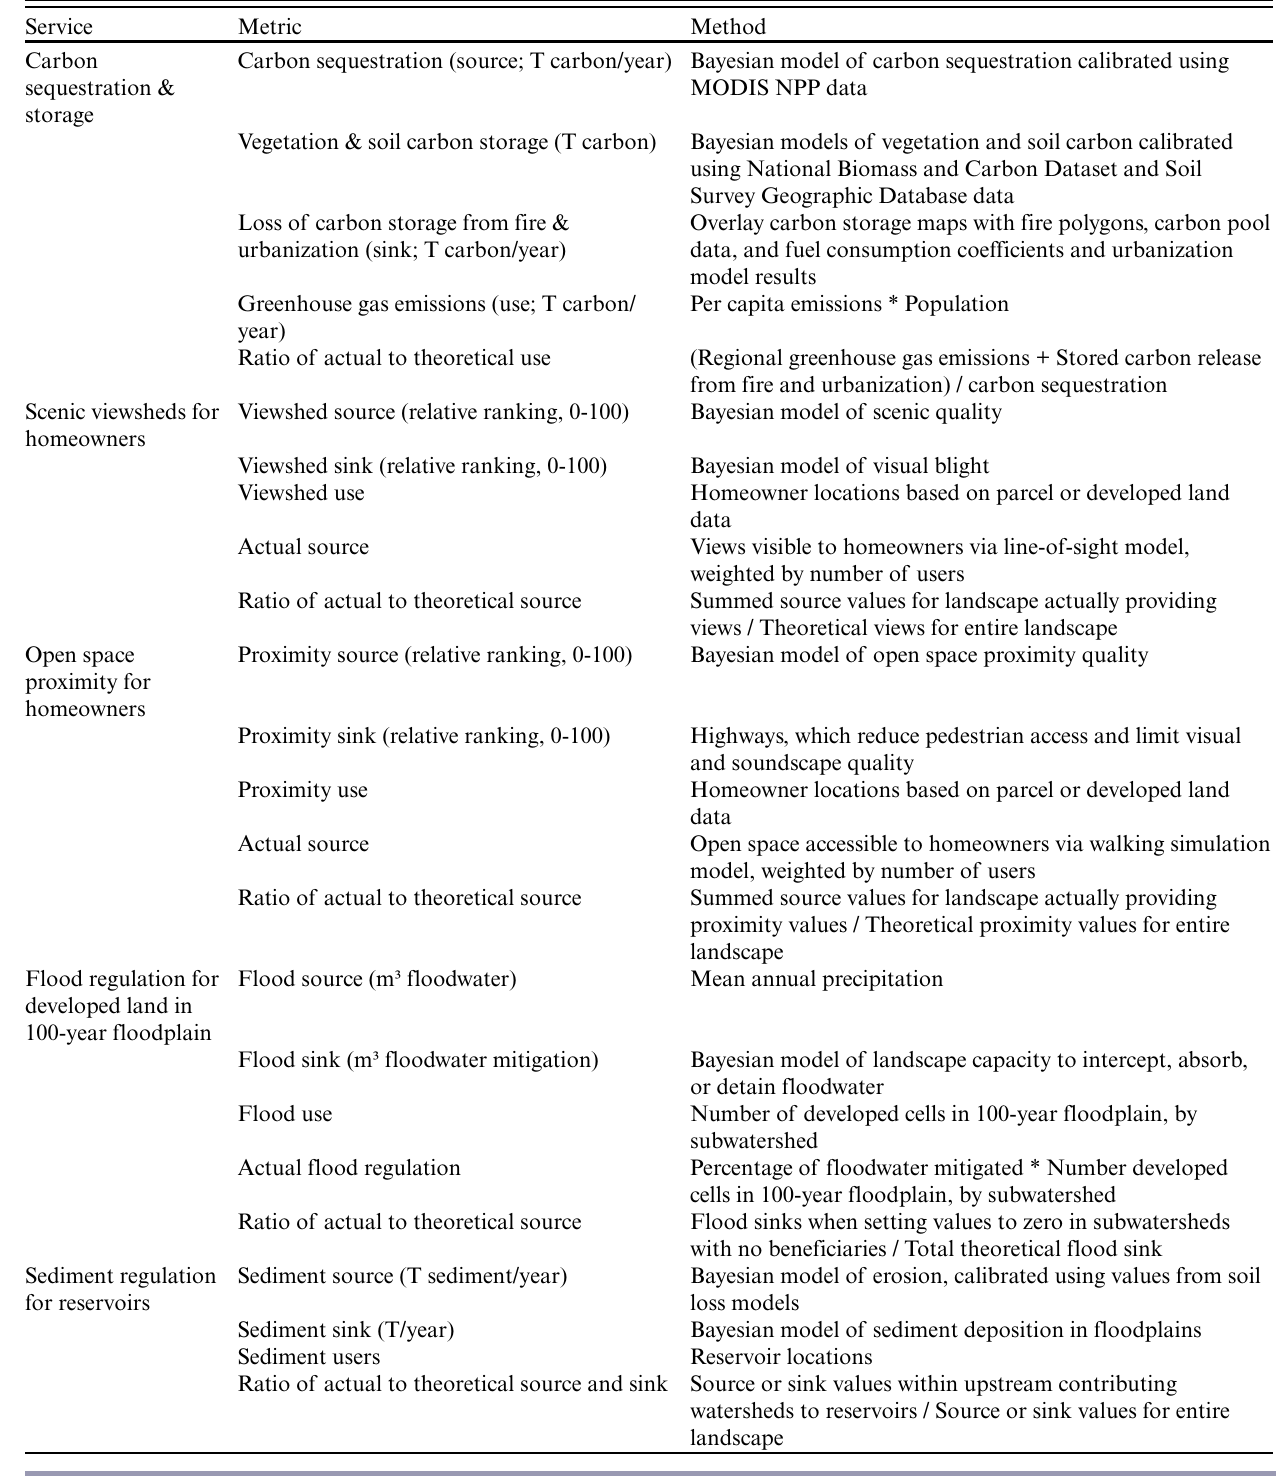
Table 1 . Methods and metrics for quantifying ecosystem services in the Puget Sound